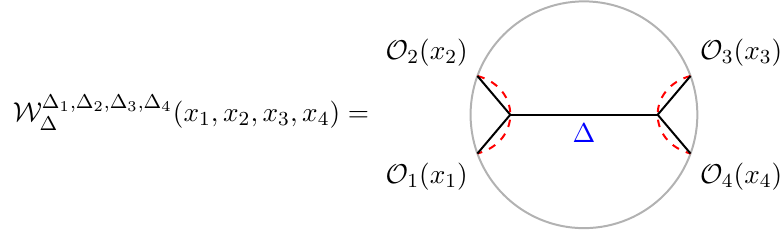
Figure 2 . The geodesic integral of (1.8), represented diagrammatically as a geodesic bulk diagram. The dashed, red curves represent the boundary anchored geodesics along which the respective bulk interaction vertices are integrated. In the literature, this is often referred to as a (four-point) geodesic Witten diagram [1]. In particular, the same diagram computes the p -adic four-point conformal partial wave when evaluated on the Bruhat-Tits tree instead of AdS [6]. (In later (cid:12)gures, locations of operator insertions will often be suppressed when no confusion is